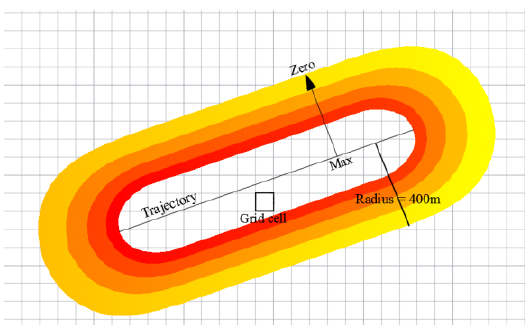
Figure 4. Illustration of the kernel surface over a line segment.